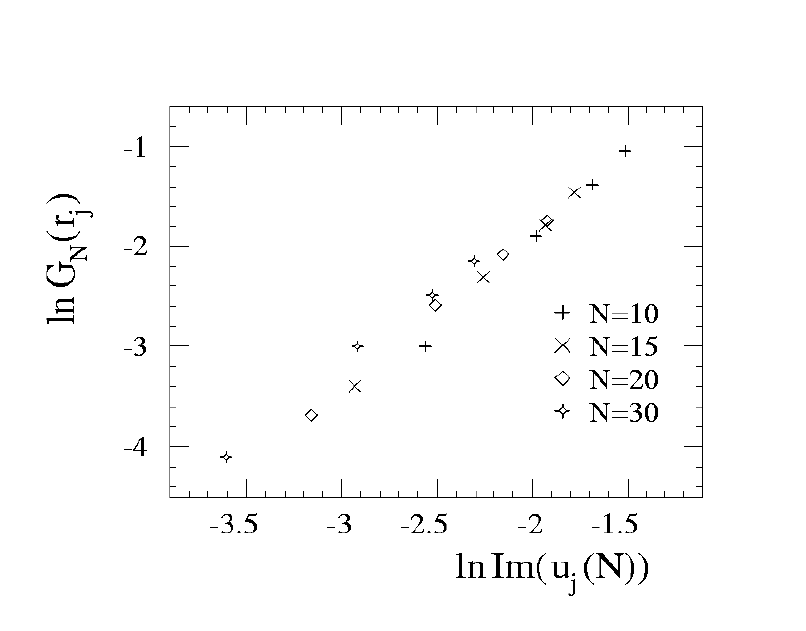
Fig. 1: Distribution of zeros for the polyalanine